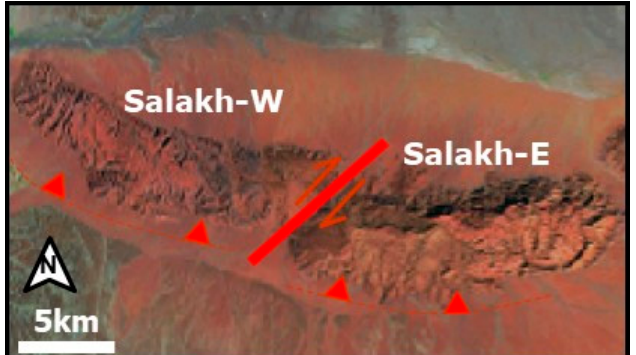
Figure 20. LANDSAT image of the Salakh E, Salakh W and the Z-shaped saddle between them. The Salakh E structure propagated farther to the foreland than Salakh W. Top Natih Formation has been uplifted to 1060 m above sea level in Salakh E, whereas its maximum uplift in the Salakh W is only around 800 m. Plausibly, this compartmental fault forms early during the arch’s evolution. As the fold segments grew and arch progressed to the foreland, the fault developed as a strike-slip fault, oblique to the regional compression, with some reverse sense of movement.